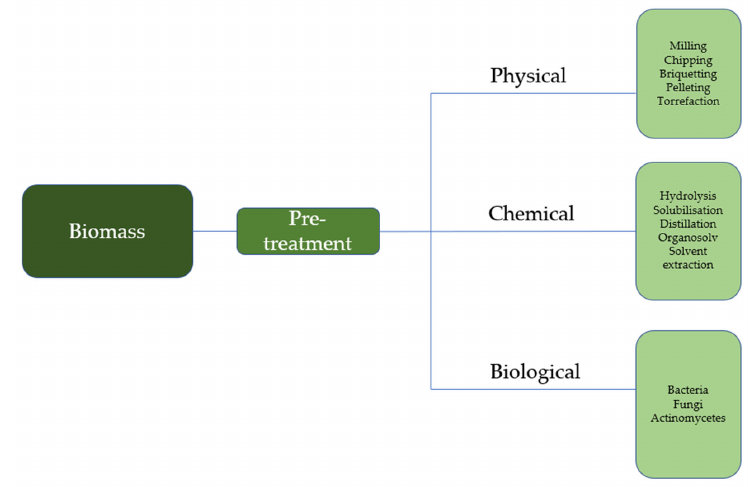
Figure 2. Classification of biomass pretreatment [32].